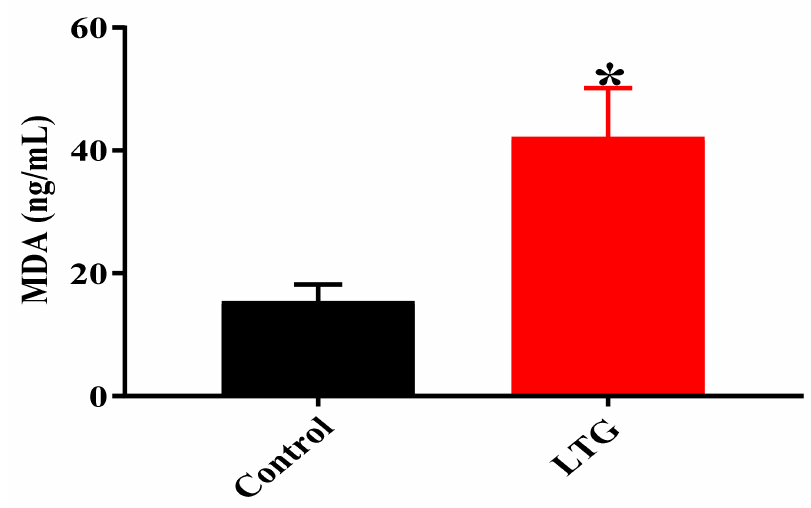
Figure 5. E ff ect of Pb acetate administration on MDA levels in the cerebellums of rats after Pb toxicity induction. Data are expressed as mean ± SEM ( n = 3); * p < 0.005 vs.